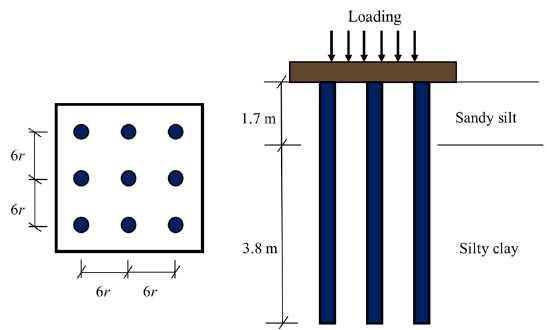
Figure 7. Layout of the pile group and subsoil